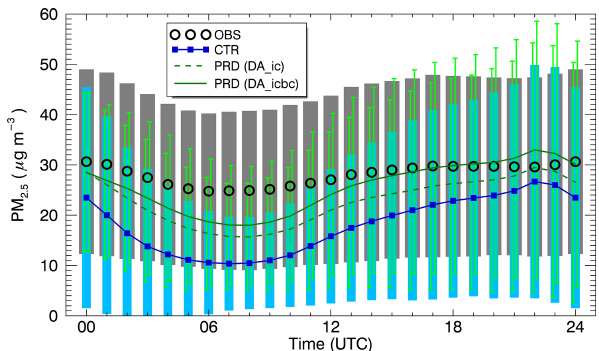
Figure 9. Averaged diurnal variations of PM 2 . 5 aggregated from all ground stations in South Korea (D2). The color and symbols are the same for observations (OBS) and the control run (CTR) as in Fig. 5. The 1d predictions only with updated initial conditions (DA_ic) and with initial and boundary conditions (DA_icbc) are presented by dashed and solid green lines, respectively. 1 standard deviation ( σ ) is also plotted for each case using vertical bars. The left and right vertical bars indicate ± σ for DA_ic and DA_icbc,